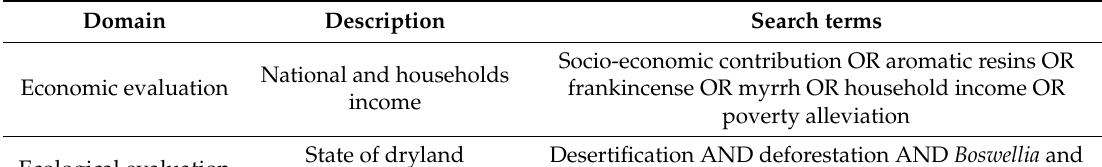
Table 1. Search terms and